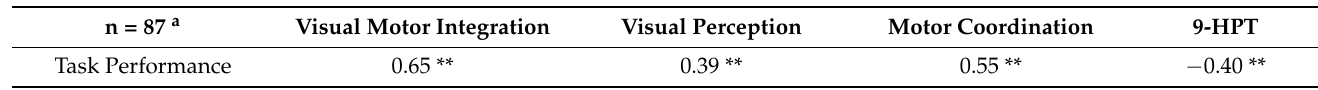
Table 7. Results of correlations between two different instruments (Beery™VMI-6 and 9-HPT) and